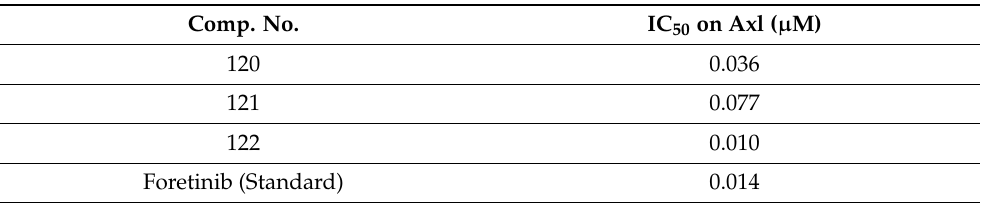
Table 4. The inhibitory activities of 1,3,4-oxadiazol acetamide moiety containing6,7-disubstituted quinoline derivatives against Axl. Comp. No.